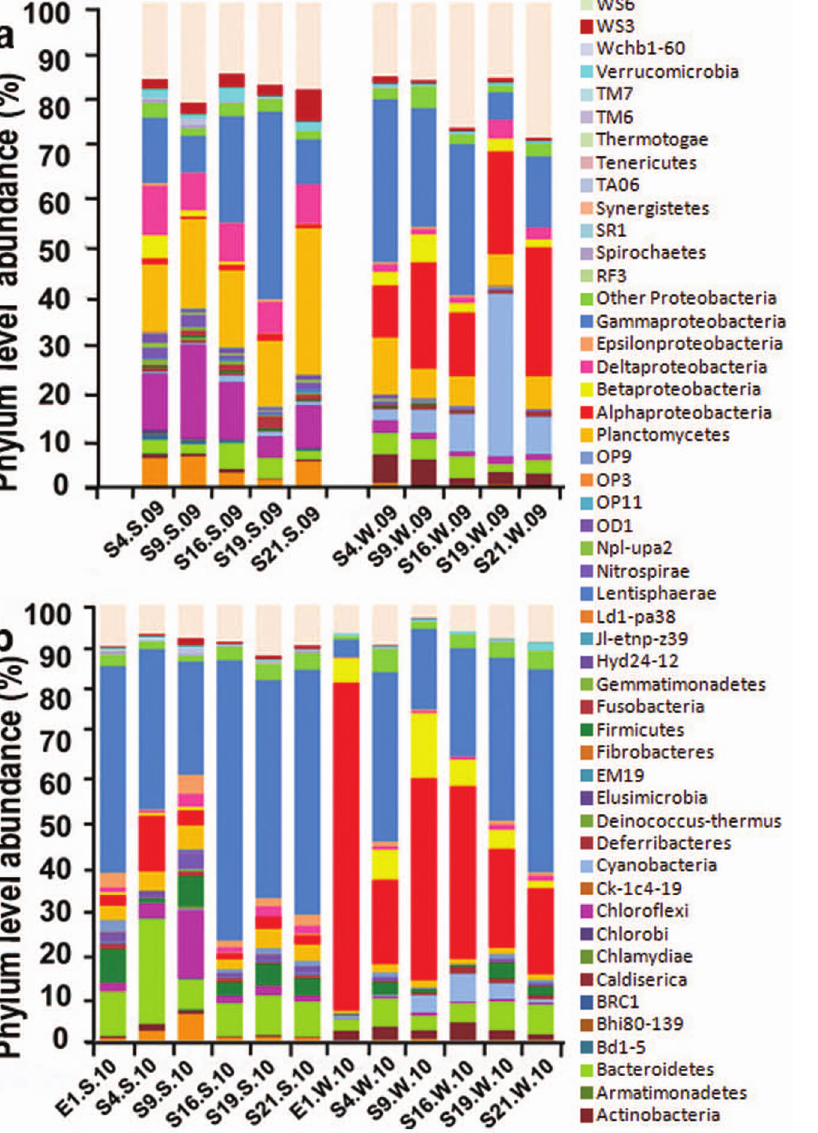
Figure 2. Taxonomic classification of qualified bacterial reads retrieved from samples of the surface sediment and its overlying bottom water at different stations in (a) summer and (b) winter. Qualified reads were assigned to different phyla using the RDP classifier in the QIIME pipeline with a confidence threshold of 80%. ‘‘W’’ represents water samples, ‘‘S’’ represents sediment samples, ‘‘09’’ represents samples collected in the summer of 2009, and ‘‘10’’ represents samples collected in the winter of